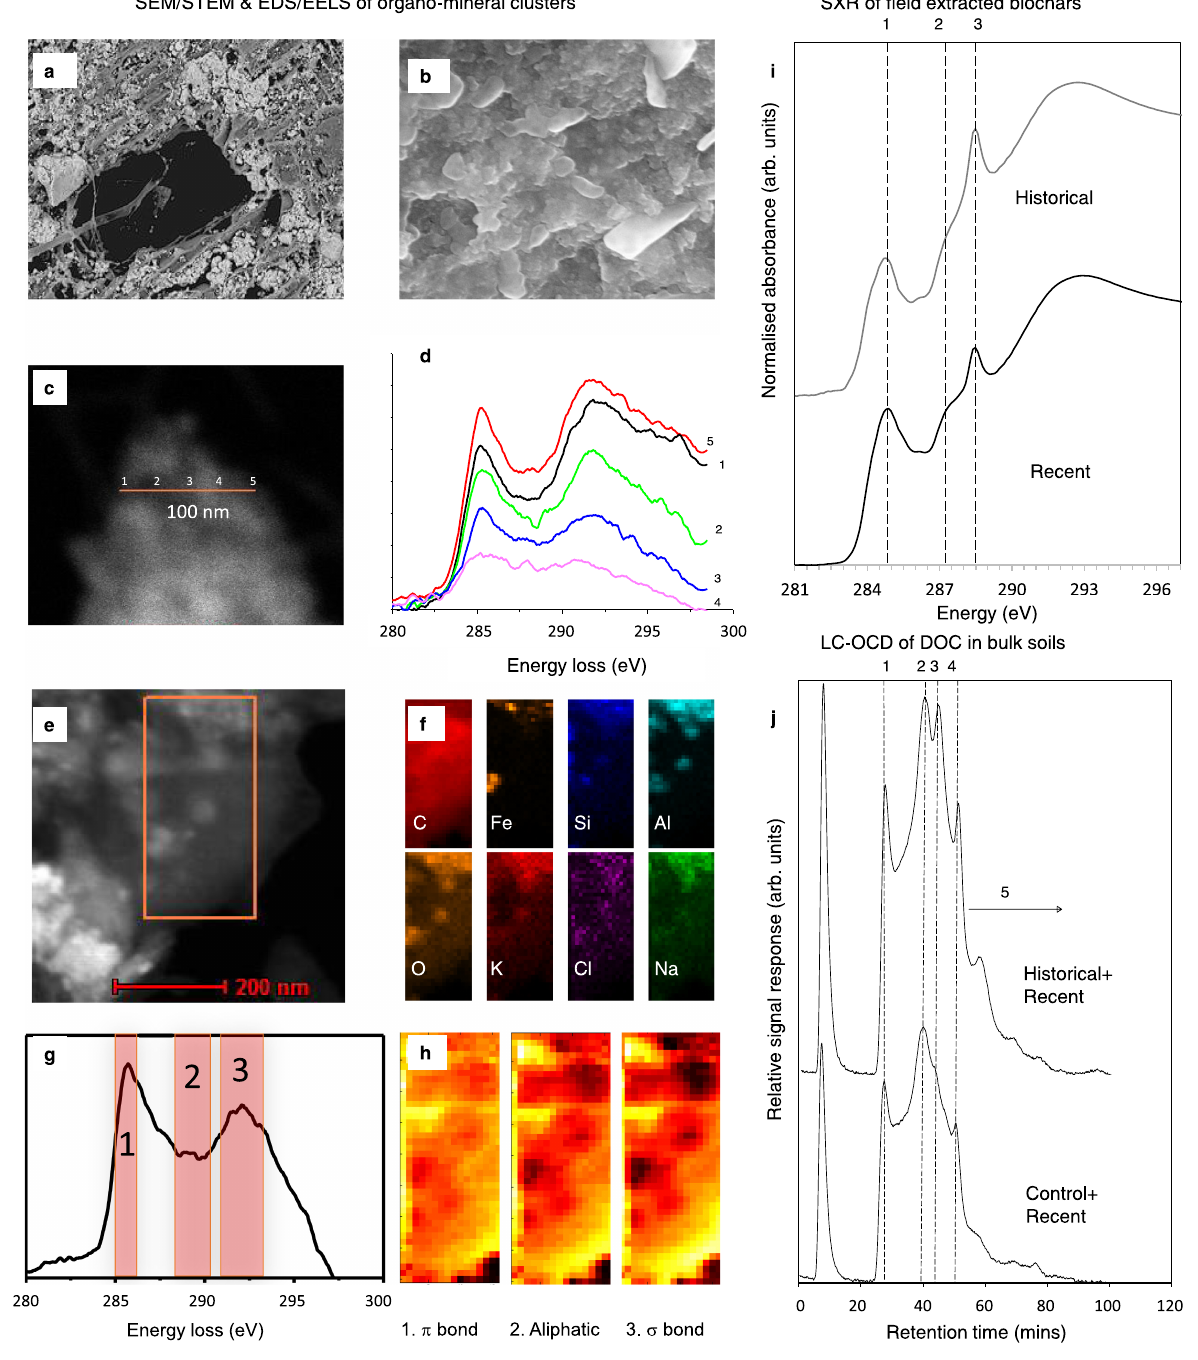
Fig. 4 | In situ spectromicroscopic analysis of the organo-mineral coating on biochar surfaces and pores. a A pore in biochar that was recovered from the Historicalplots(scanningelectronmicroscopy[SEM]).Bar,50 μ m. b Surfaceofthe organo-mineral layer inside the biochar pore from Historical plots (SEM). Bar, 200nm. c Organo-mineral clusters on a biochar surface from the Control+Recent [HAADF-STEM]); d the electron energy loss spectra (EELS) at positions 1 – 5 of the